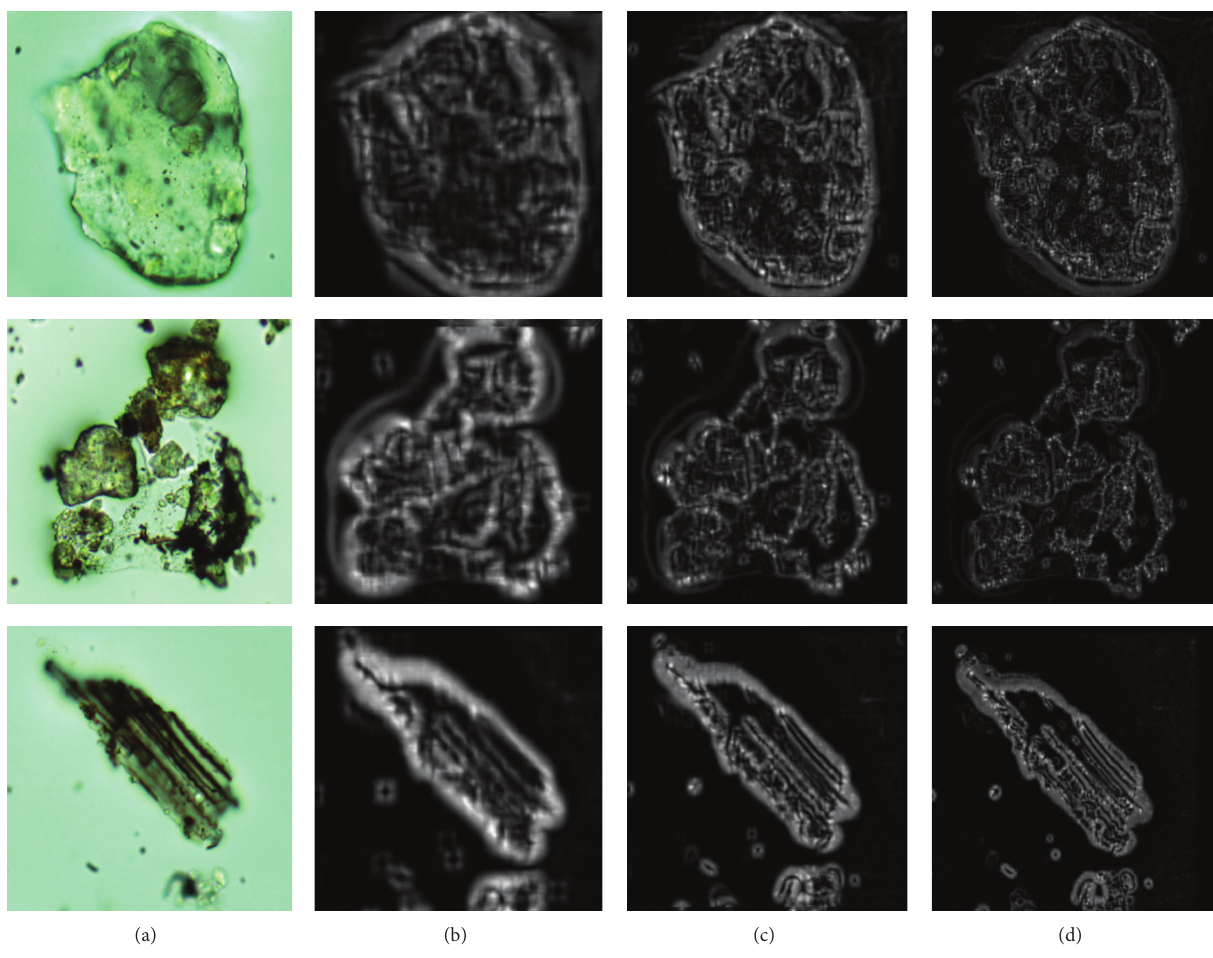
Figure 6: Different 𝐽 -image calculation under different